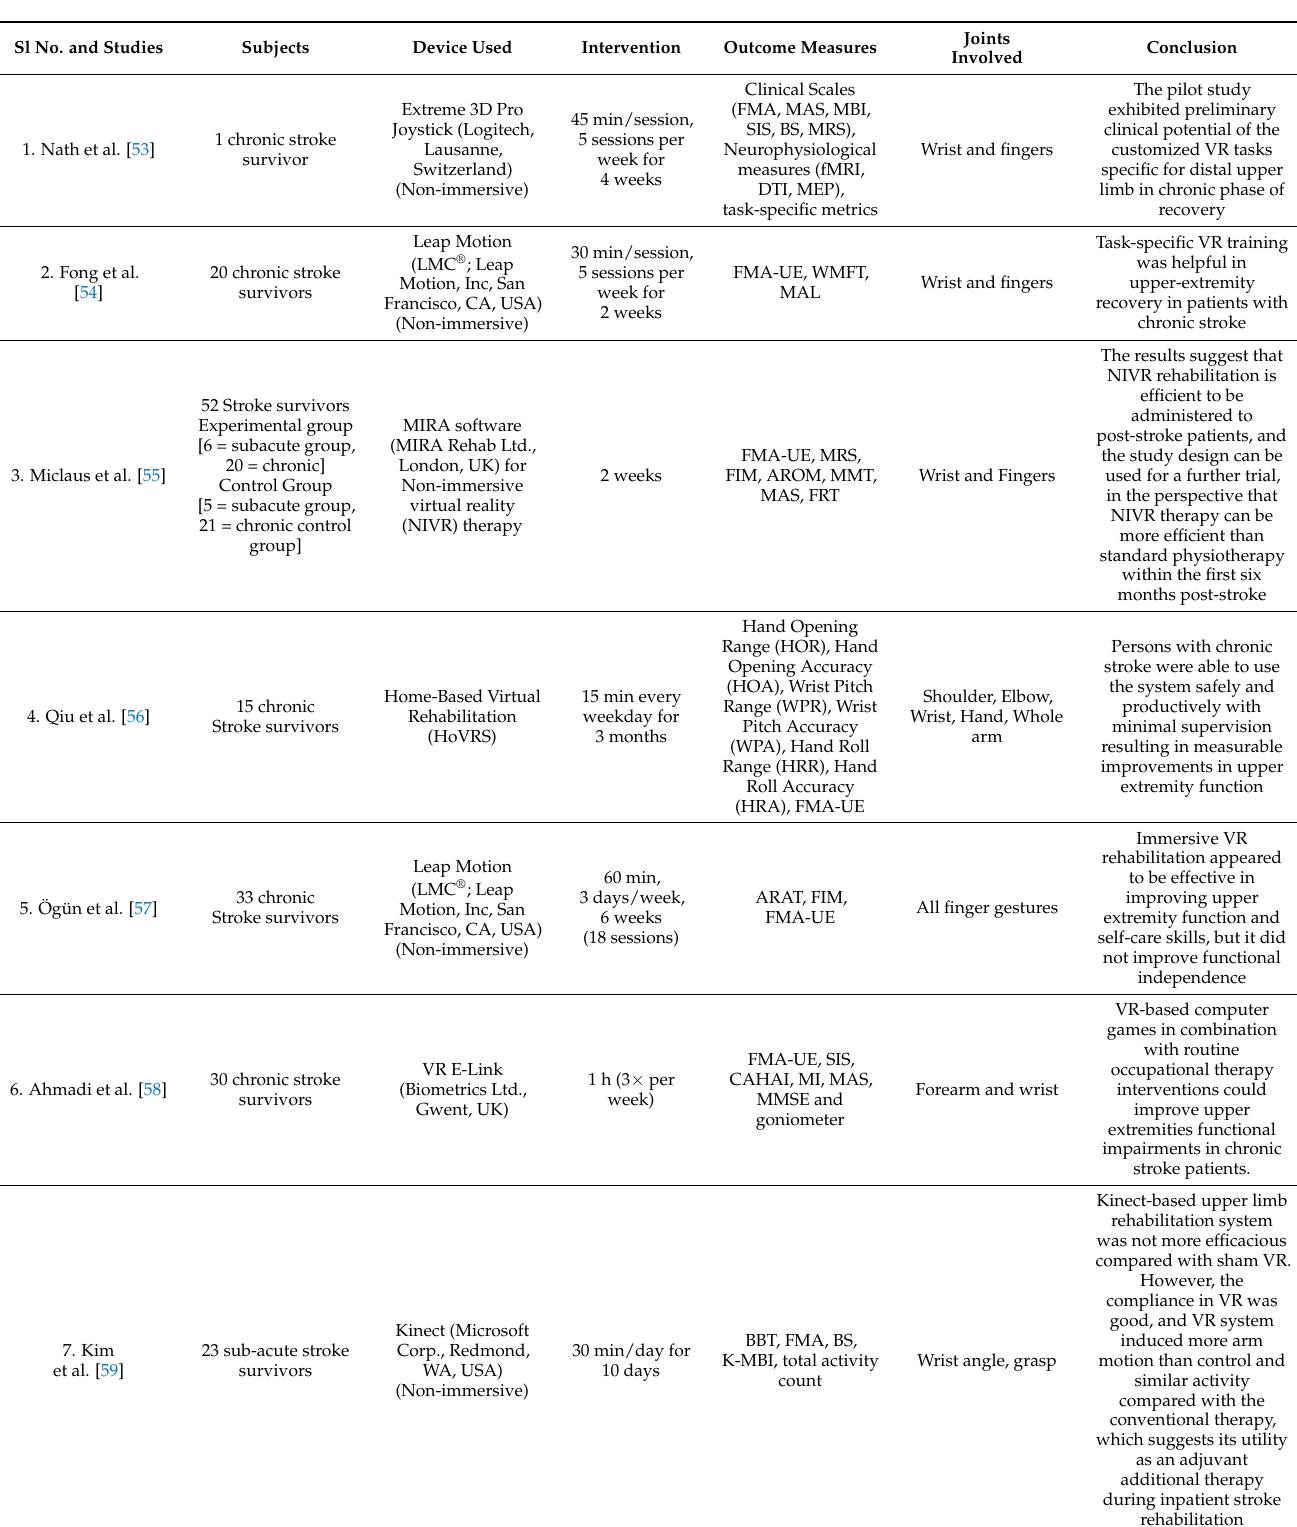
Table 1. VR-based studies primarily focusing on distal upper